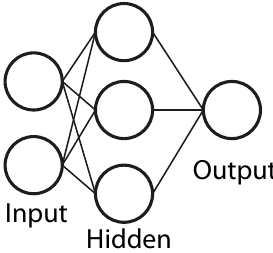
Figure 5. An Artificial Neural Network (ANN) for predicting an output value based on two input values [2]. It has one hidden layer with three nodes. The lines between the nodes illustrate that the ANN is fully connected and the forward flow of calculations in the